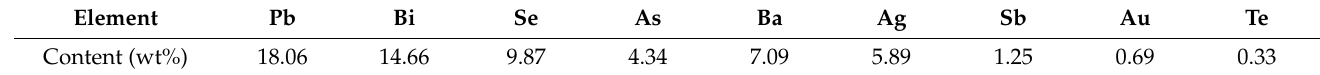
Table 3. Main chemical composition of H 2 O 2 = 28.8 g/L leach residue.